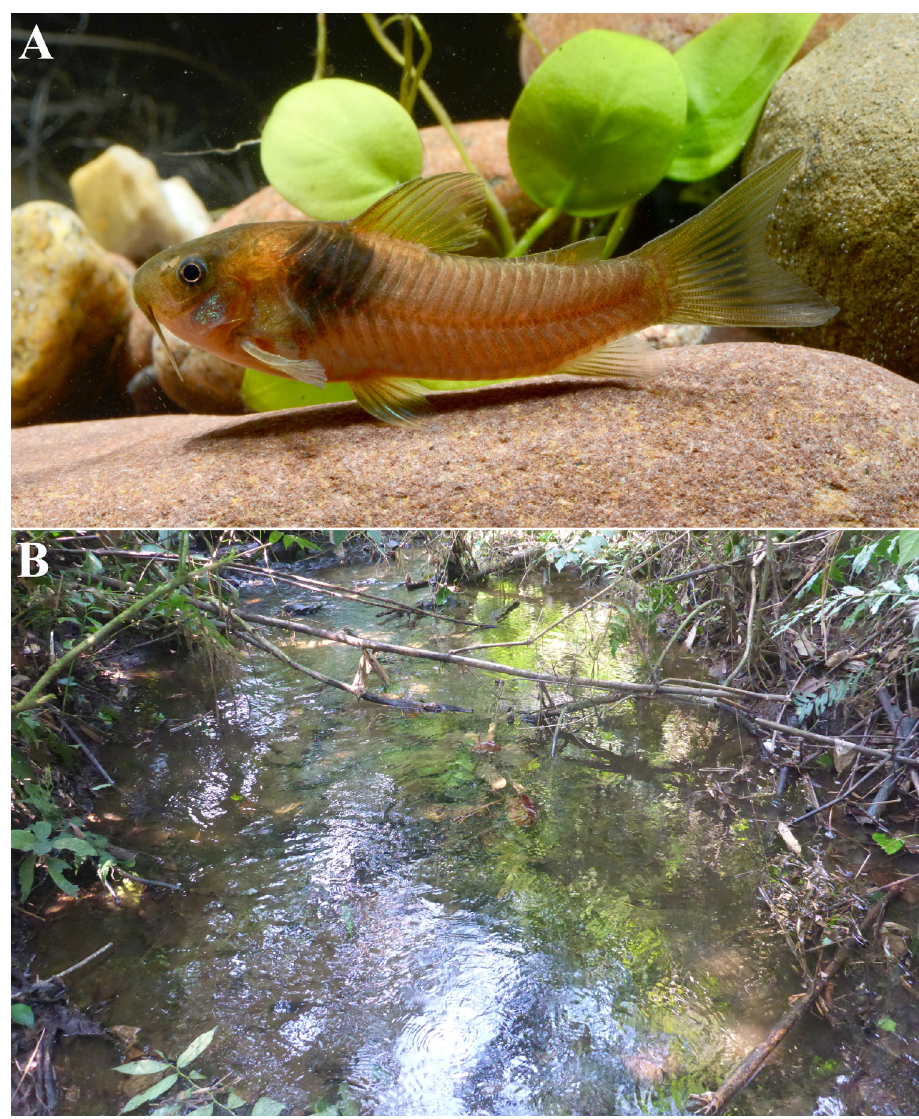
FIGURE 8 | Uncatalogued aquarium specimen of Corydoras maclurei ( A ) showing its typical color pattern in life (lateral view), collected in its type-locality ( B ), a small stream tributary to the rio Araza, rio Madre de Dios basin, rio Madeira basin in